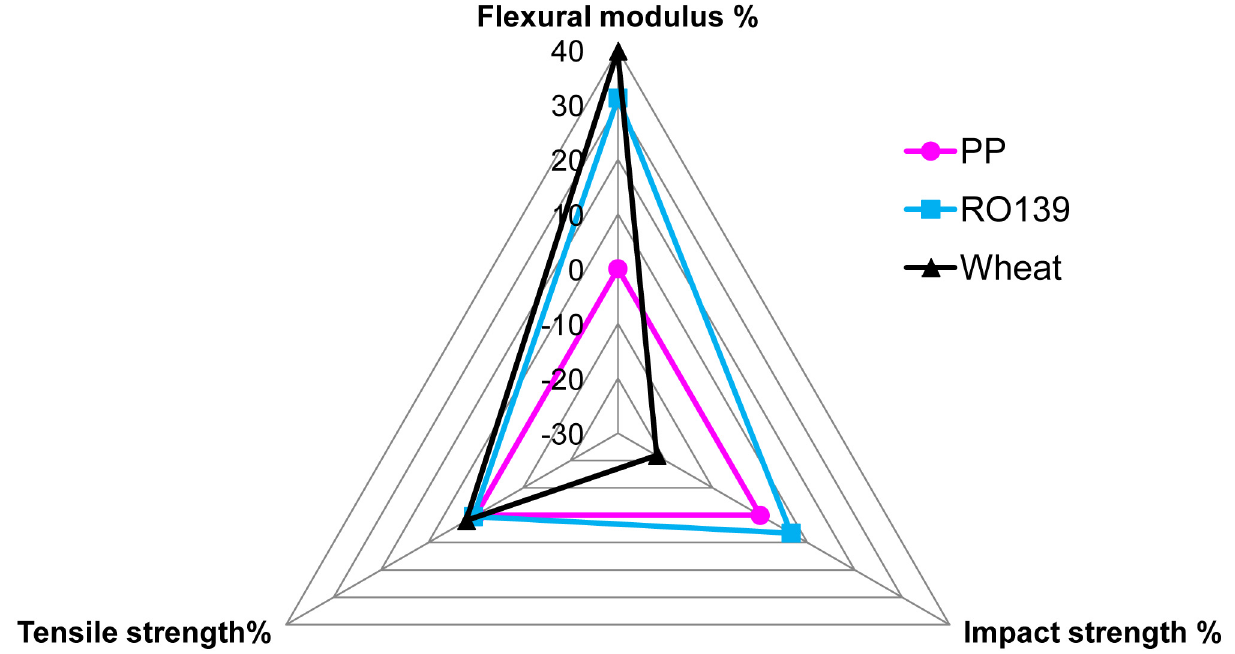
Fig 3. Mechanical trait-based index comparison of the best performing soybean (RO139) stem fiber/polypropylene (SS/PP) composite with wheat straw/polypropylene (WS/PP) composite and pure polypropylene (PP). Composites from RO139 (blue) were better than pure PP (magenta) for all three mechaical traits and outperformed WS/PP (black) for impact